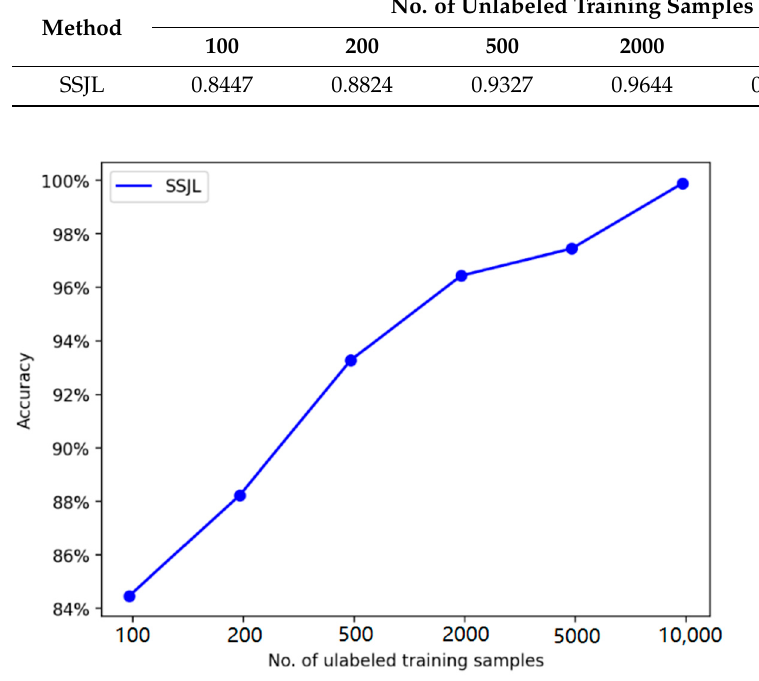
Diagnosis accuracies of different numbers of unlabeled training samples on the CWRU dataset.